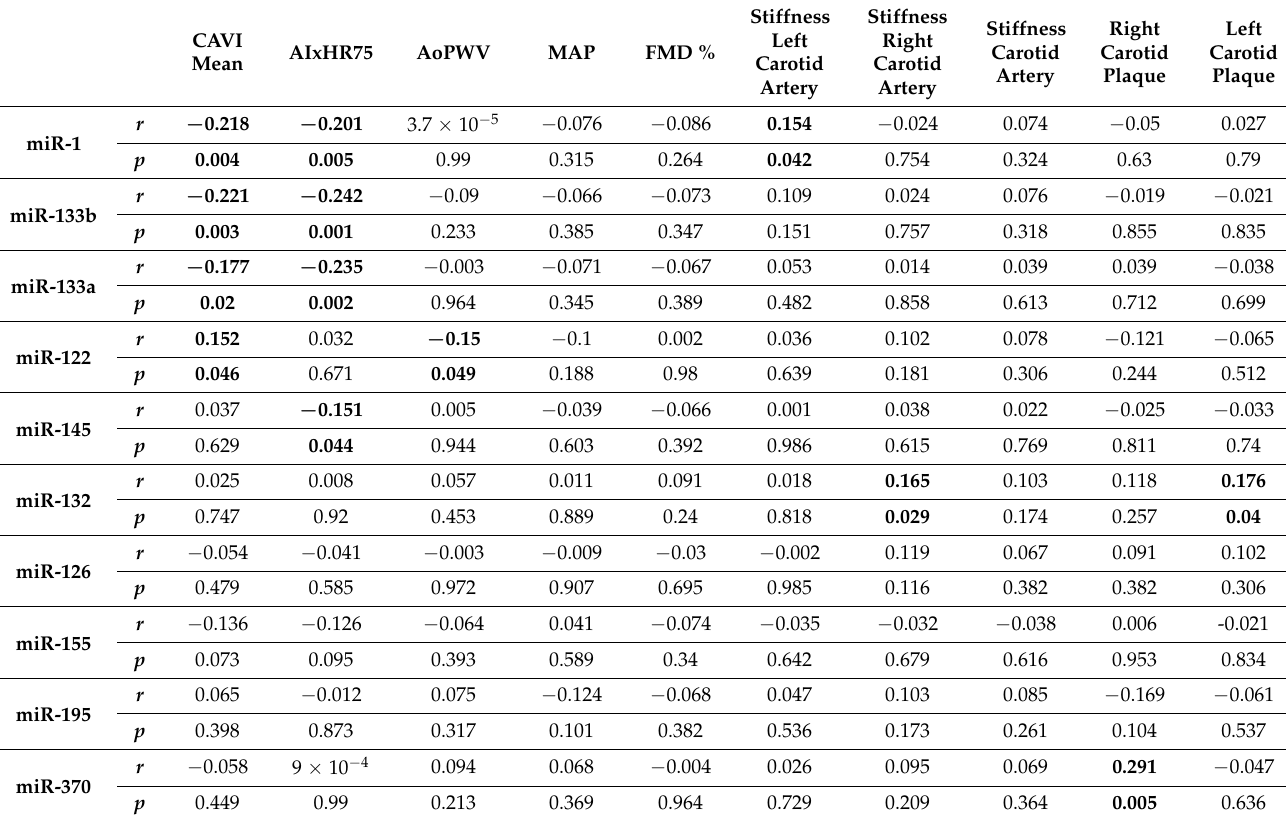
Table 3. Pearson correlation.